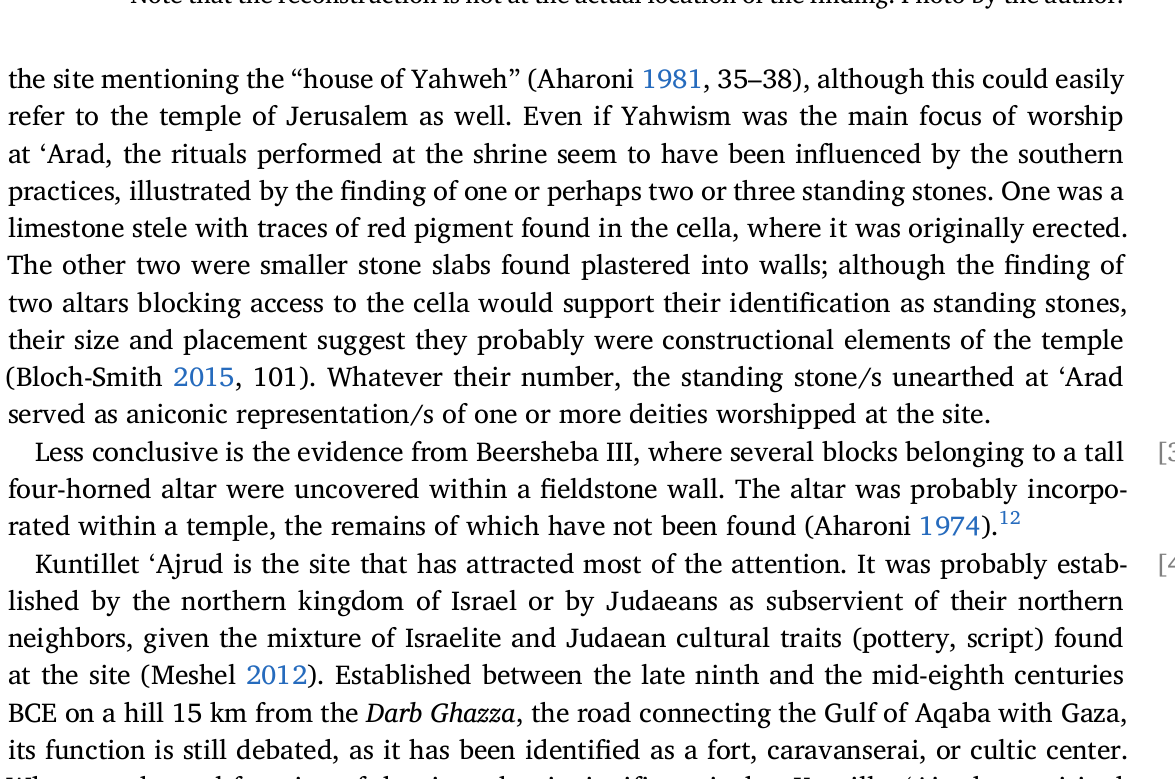
Figure 9 Reconstruction of the small cultic cell ( debir ) of the temple at Tel ‘Arad: view from the east. Note that the reconstruction is not at the actual location of the finding. Photo by the